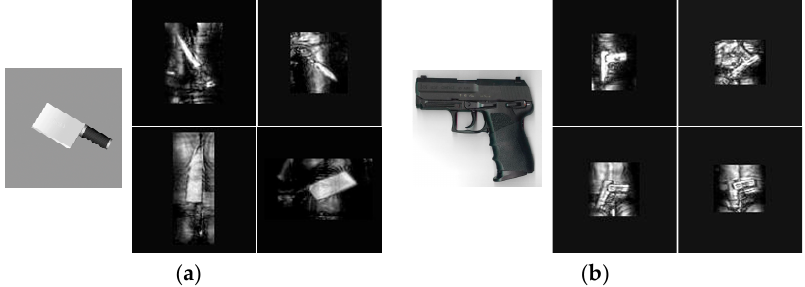
Figure 5. Similarity comparison. The contrast images of optics and terahertz system of similar objects. ( a ) Knife. Left column shows an optical image of kitchen knife and the right column shows four different types of terahertz knife images and they are assumed as the same object. ( b ) Handgun. Left column image is the optical image of gun and right columns show four terahertz images which are imaging from different angles.